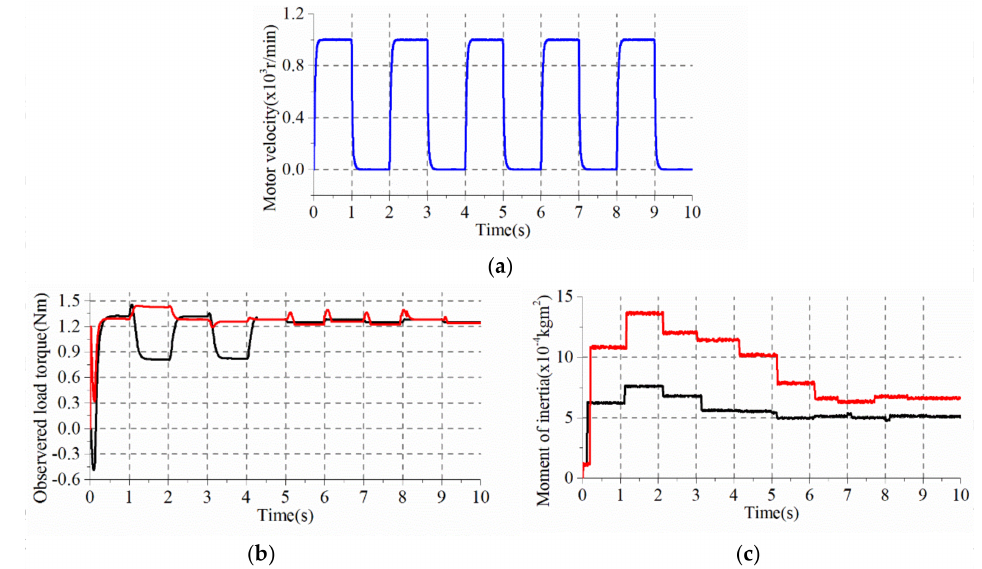
Figure 6. Comparison of two algorithms with initial value ˆ J ( 0 ) = 0.2 J and 1.2 Nm load torque, 0–1000 rpm repeated step speed command. ( a ) Speed response (blue); ( b ) Observed load torque ˆ T L (black line denotes AKO-RLS result, red line denotes KO-RLS result); ( c ) identified inertia ˆ J (black line denotes AKO-RLS result, red line denotes KO-RLS